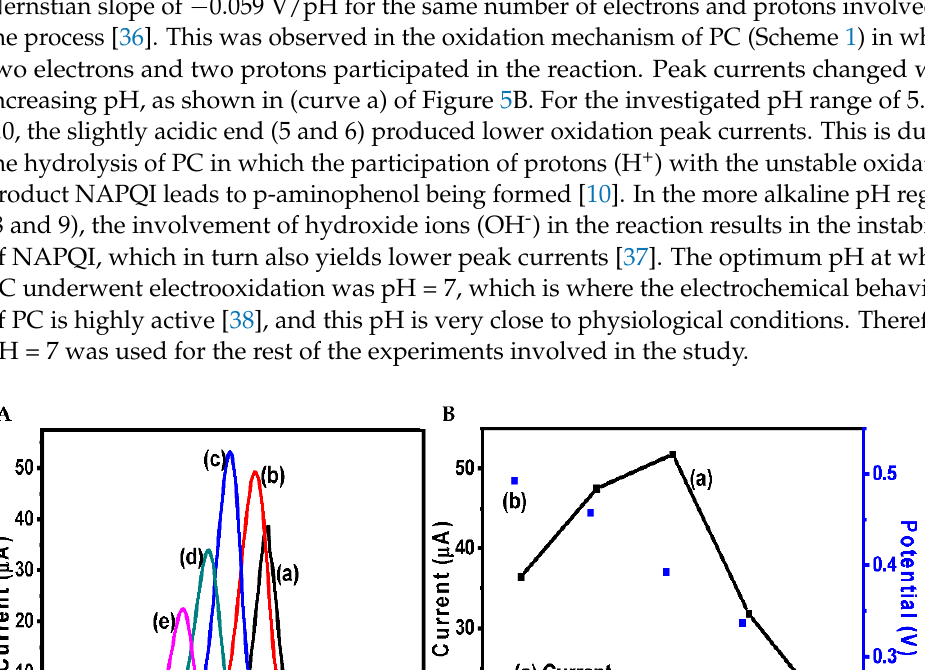
Scheme 1. The electrochemical oxidation mechanism for PC (N-acetyl- p -aminophenol) Re- printed/adapted with permission from Ref. [9]. © 2022, IEEE.